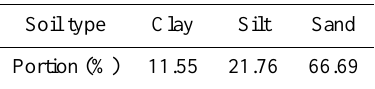
Table 2. Granulometry of the experimental plot. The soil used for the plot can be classified as sand according to the International So- ciety of Soil Science (ISSS).